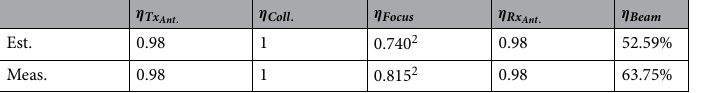
Table 6. All components’ efficiency and overall beam efficiency, estimated and